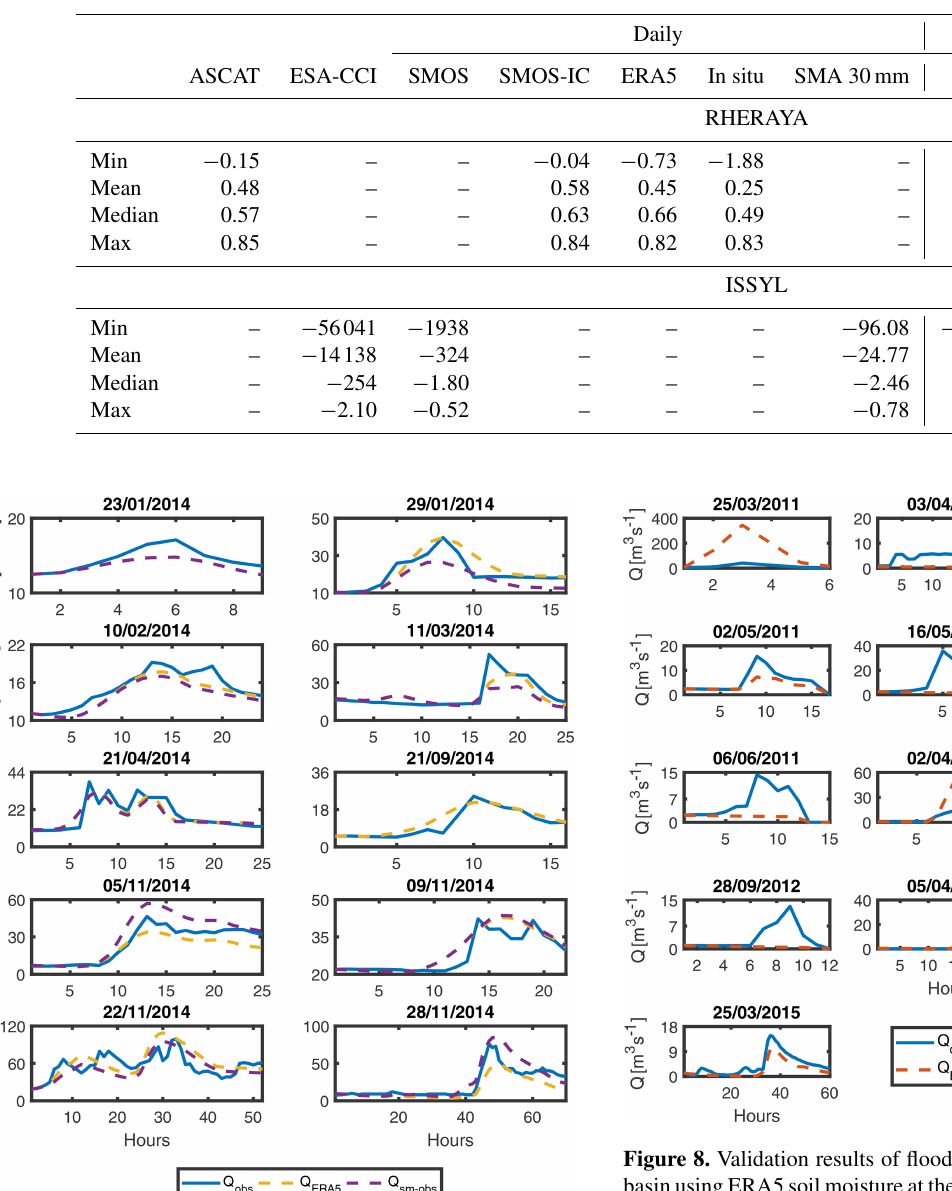
Table 8. Performance of the SCS-CN model in terms of NS coefficients for the Rheraya and Issyl events, using the daily or hourly time steps for the different soil moisture products.